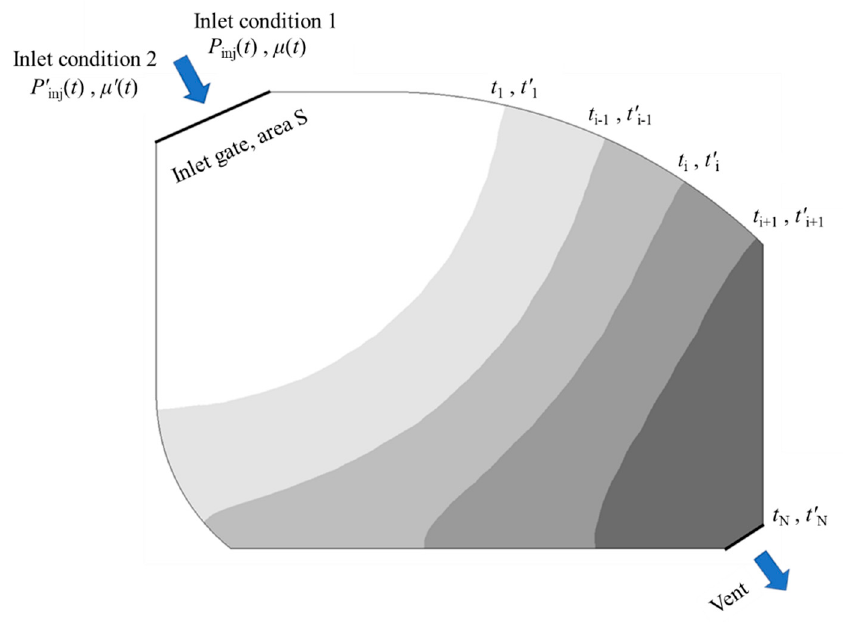
Figure 2. Schematic progression of the flow front for two different inlet conditions in a generic mold cavity: the inlet conditions lead to the same filling pattern but at different times.